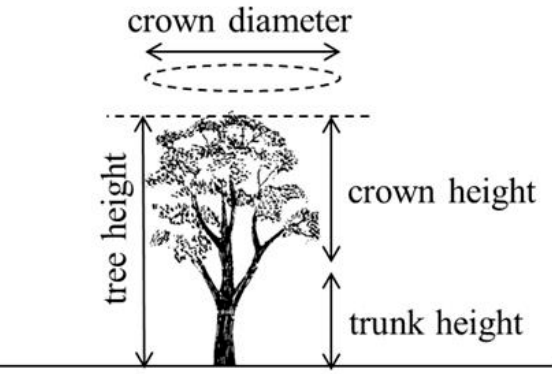
Figure 2. Schematic diagram indicating canopy dimensions required to estimate canopy volume.